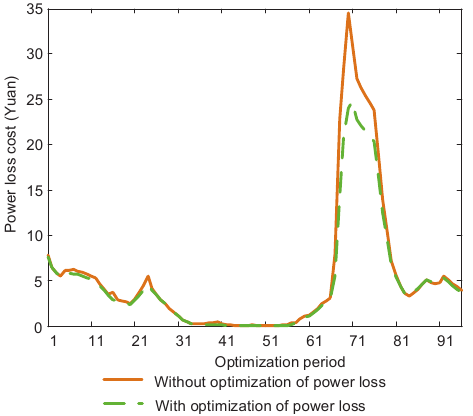
Figure 18. Power loss cost comparison between with and without optimization of power loss on Day 2 of Scenario